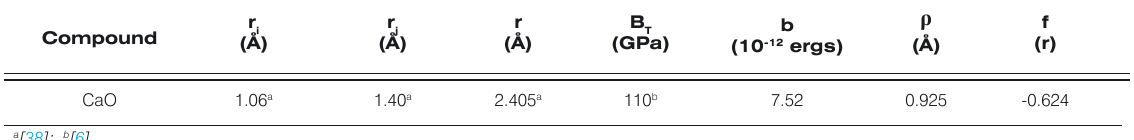
Table 1. Input data and model parameters of the crystal.